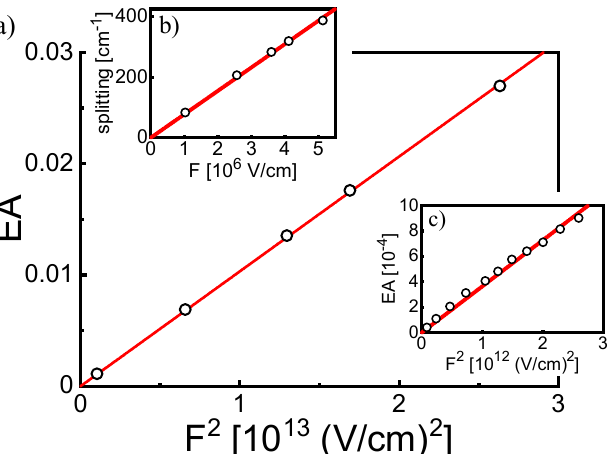
Figure 9. Behavior of the 3E state of the RBY(PF 6 ) 2 system in the electric field. The electric field dependence of the EA signal calculated by the TDDFT method is shown in part ( a ) on the 10 6 V/cm field scale, and for the experimental EA signal, it is shown in part ( c ) on the 10 5 V/cm field scale. The graphs are linear with the second power of the applied electric field strength. Part ( b ) of the figure shows the linear dependence on the electric field of splitting the two components of the 3E state, as calculated by the TDDFT method. We emphasize here that in order to interpret the EA behavior of RBY(PF 6 ) 2 solid films, there is no need to invoke the charge localization model. According to this model, previ- ously applied to RBY systems [30], the anticipated change Δ μ in the dipole moment was attributed not to the degeneracy of excited states but to the transfer of an electron from the Ru metal center to a single bpy ligand. However, the asymmetric charge redistribution in a molecule having a ground state with D 3 symmetry requires the crude assumption of breaking the symmetry of the molecule in Franck–Condon states. While environment-in- duced Franck–Condon state distortion can be envisaged in disordered liquid or glassy systems, the present EA results for the solid neat RBY(PF 6 ) 2 films with possible D 3 site symmetry for the RBY ions can be reasonably well interpreted as discussed above without assuming such distortion in the excited state.